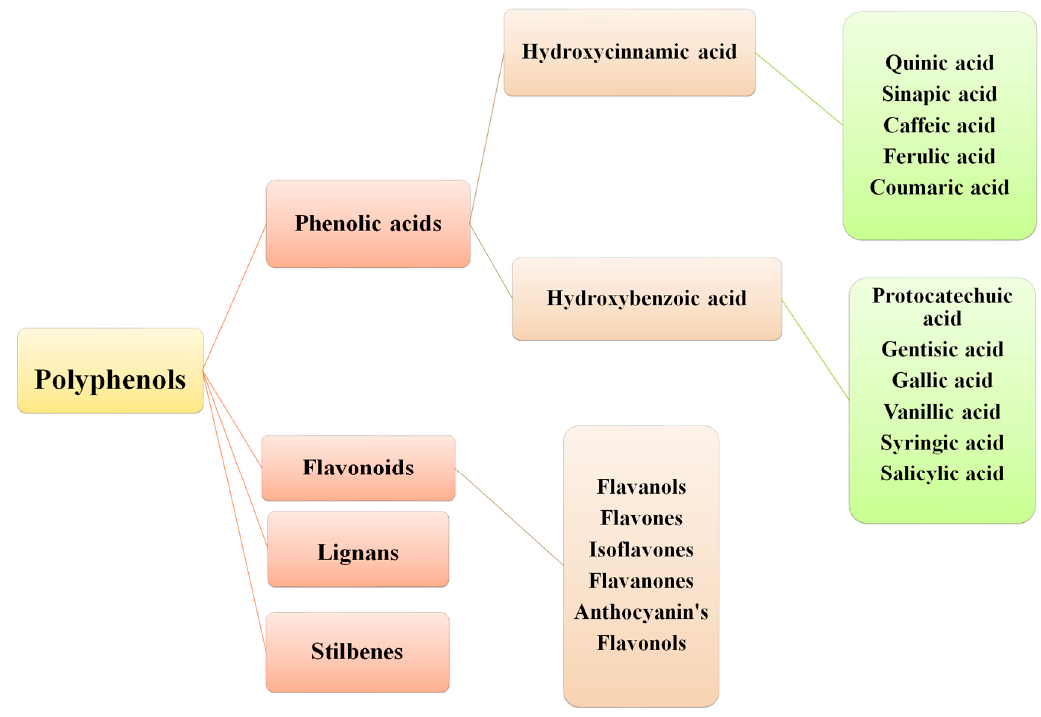
Figure 2. Classification of polyphenols.